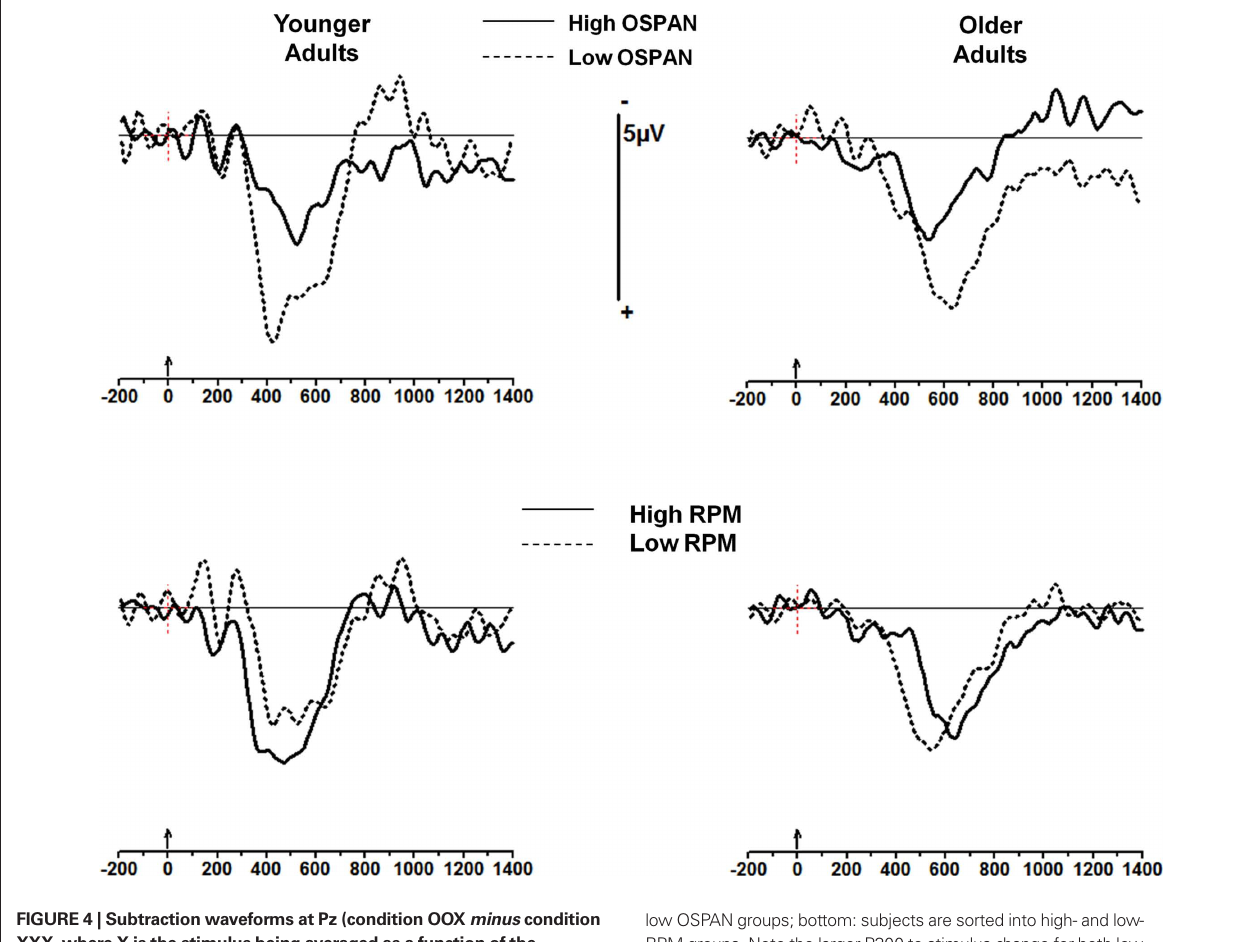
low OSPAN groups; bottom: subjects are sorted into high- and low- RPM groups. Note the larger P300 to stimulus change for both low OSPAN groups, and the smaller (and in fact inverted) effect for the